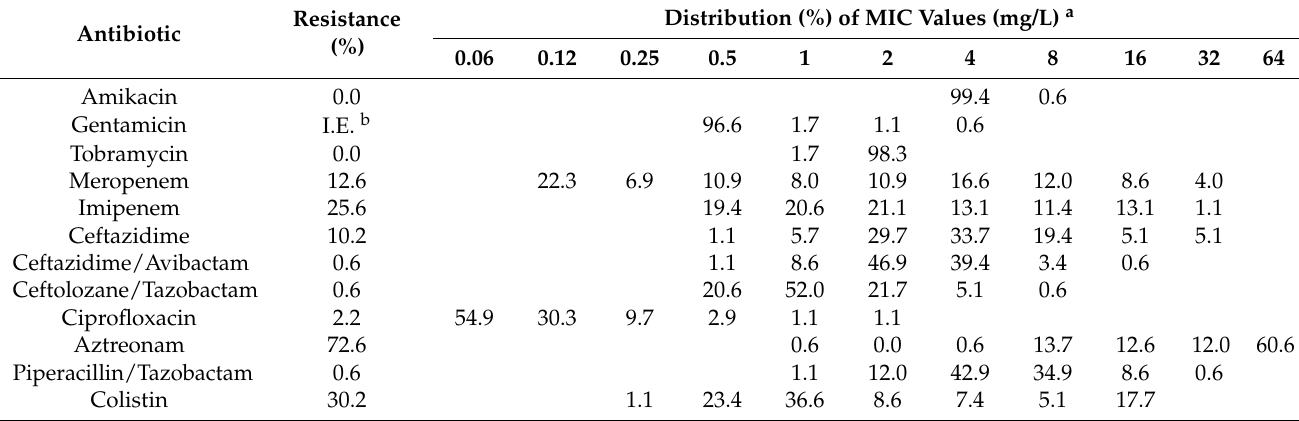
0.6 a Vertical, bold lines denote breakpoint values for resistance for each antibiotic (EUCAST Clinical Breakpoint Table v. 10.0). White fields denote concentration range of each tested antimicrobial agent. Susceptibility profiles of the 175 isolates to 12 antibiotics are presented in Supplementary Table S5. MIC values higher than the highest concentration tested are given as the lowest MIC value above the range. MIC values equal to or lower than the lowest concentration tested are given as the lowest concentration tested. b I.E. = insufficient evidence that Pseudomonas spp. are good targets for therapy with the agent (Ref. EUCAST)—no breakpoint value